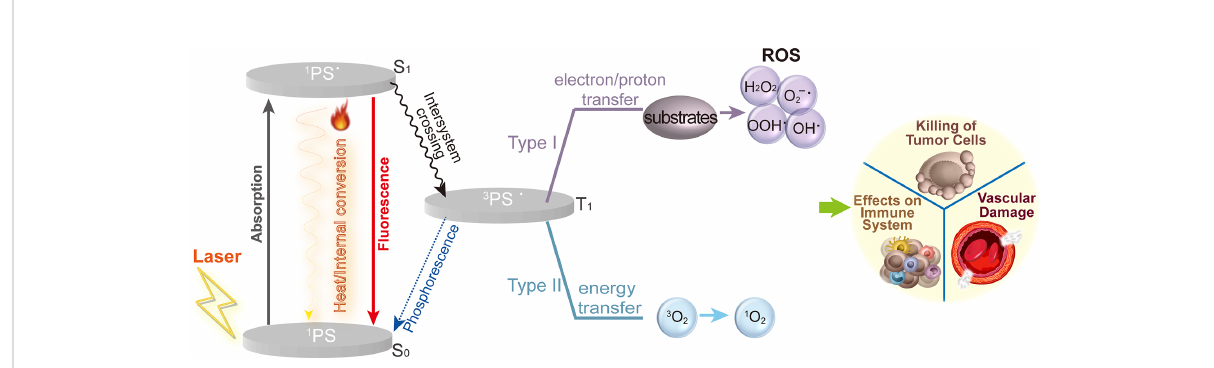
FIGURE 1 A generalized diagram depicting PDT for prostate cancer. PS was administered intravenously to patients at various times before LED excitation (depending on the type and dose of PS). The optical fi bers are placed within plastic catheter needles that are positioned and guided by transrectal ultrasound and a brachytherapy-type template to the prostate gland via the